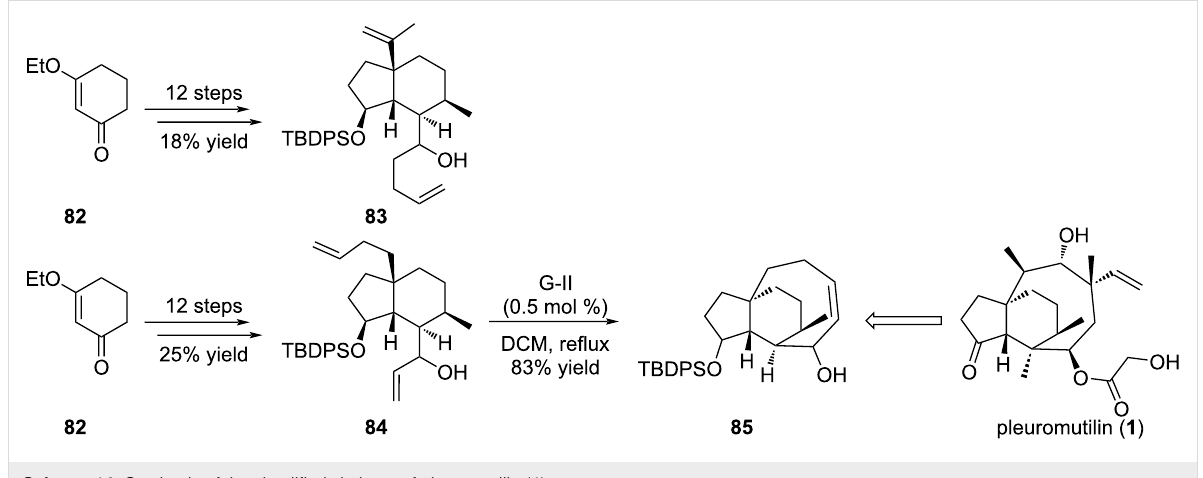
Scheme 14: Synthesis of the simplified skeleton of pleuromutilin ( 1